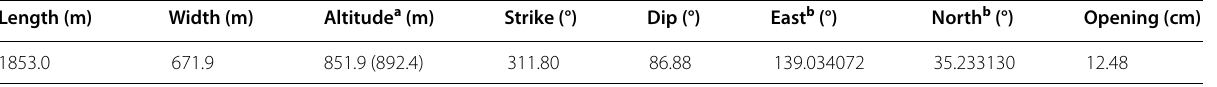
a Altitude is height above sea level of the open crack top edge, with ellipsoidal height in parentheses b East and North coordinates are in WGS84 and refer to the upper left corner of an open crack